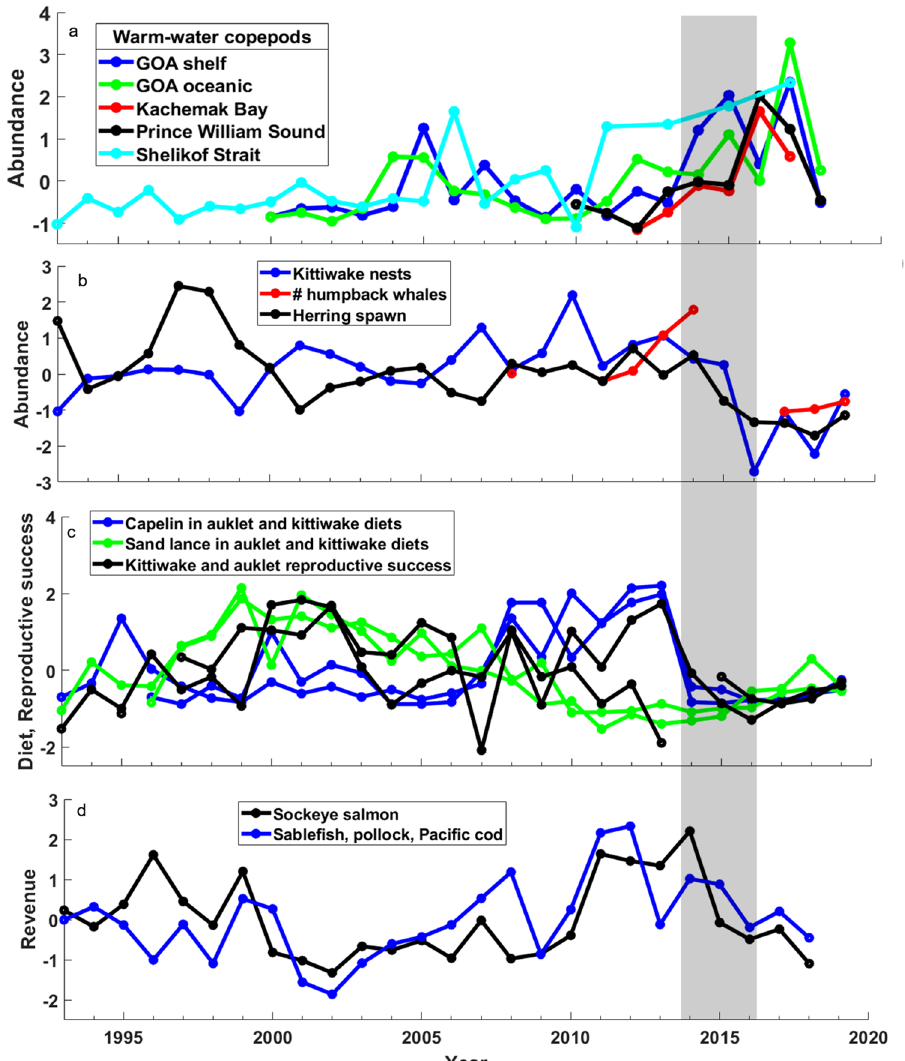
Figure 6. Long-term trends (1993–2019; a , d through 2018) in ( a ) the abundance of warm water associated copepod species in the Gulf of Alaska, ( b ) herring and herring-dependent predators in Prince William Sound, ( c ) capelin and sand lance availability to marine birds and reproductive success of kittiwakes foraging from Middleton Island, and ( d ) ex-vessel revenue for sockeye salmon and combined for the three most valuable groundfish species. Grey shading represents the 2014–2016 northeast Pacific marine heatwave. Values are z-score standardizations so the y-axes are